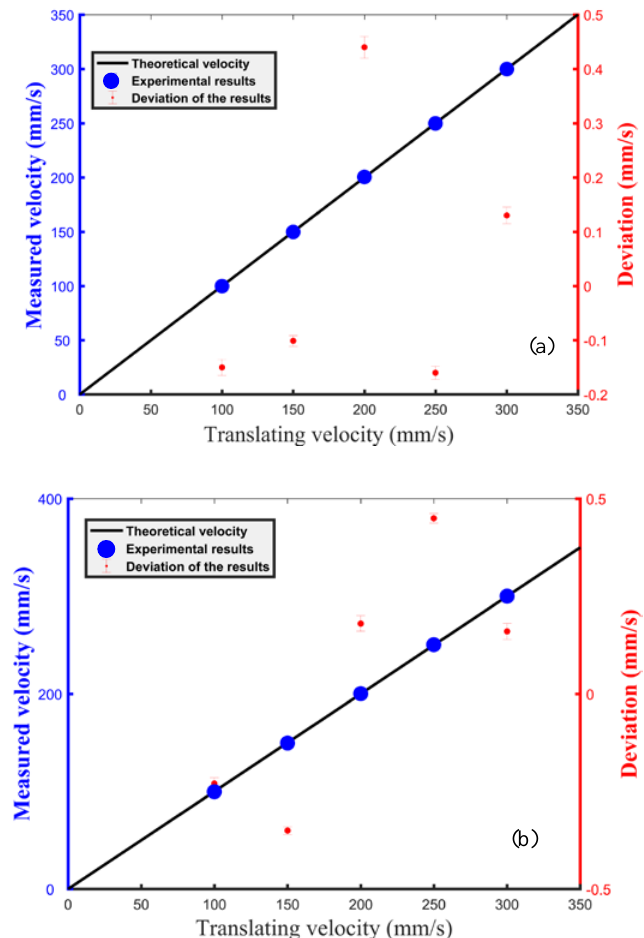
Figure 4. Results of velocity measurement. ( a ) The target is leaving the collimator; ( b ) the target is approaching the collimator.